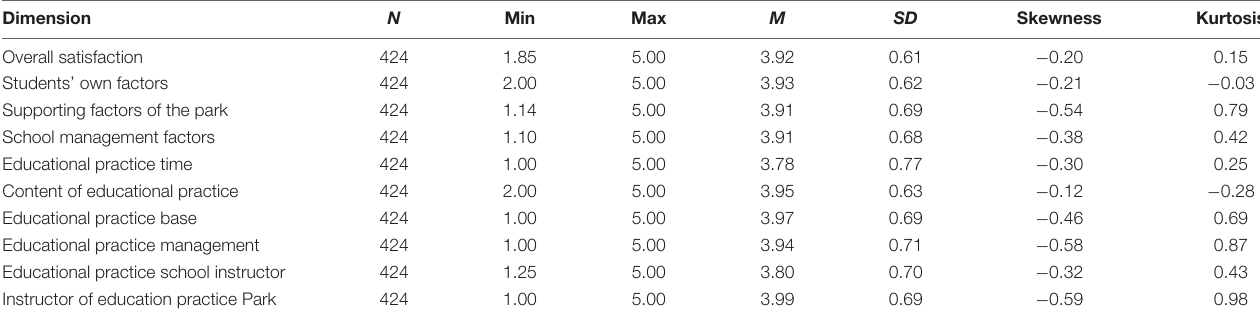
TABLE 4 | Descriptive statistical analysis results of each dimension. Dimension